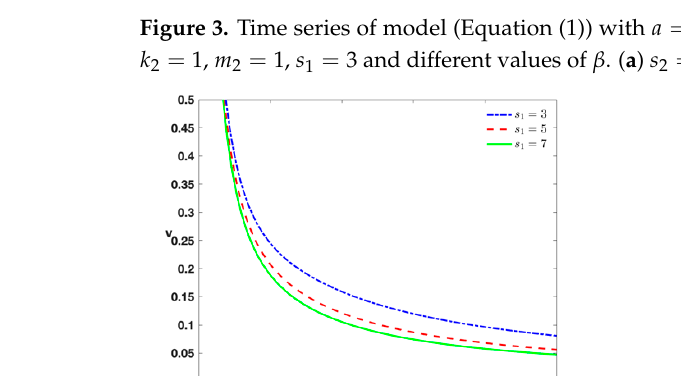
Figure 4. Time series of tumor cells with